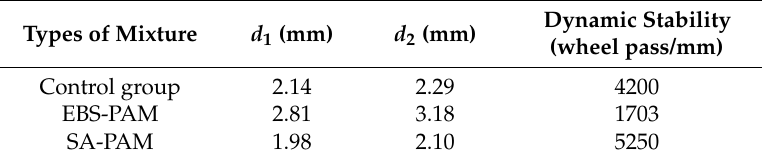
Table 8. Dynamic stability.